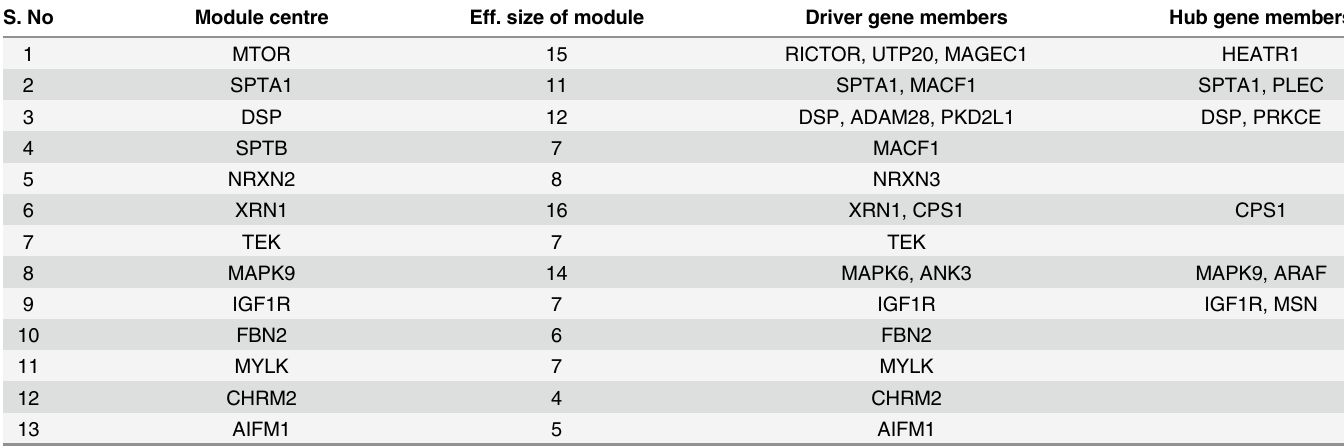
Table 6. Moduland decomposition of stage-III